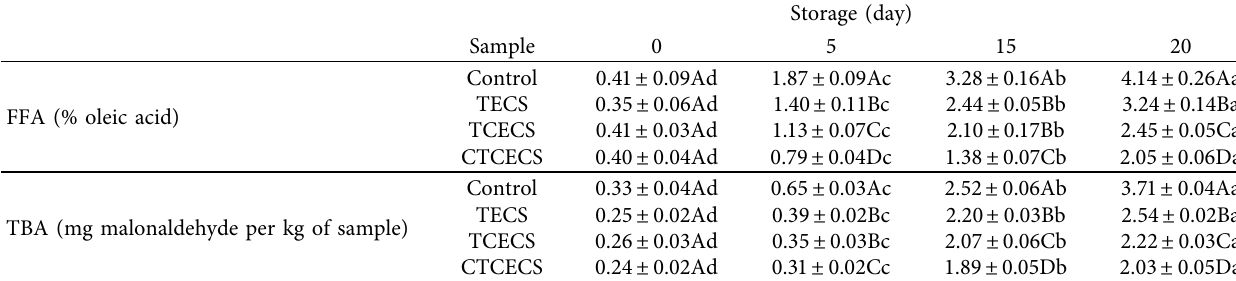
Table 2: Changes in FFA and TBA values of rainbow trout fillets during storage at 4 ± 1 ° C.